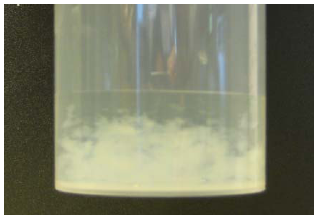
Figure 8. White precipitation in a 4.5 wt% Na-silicate solution containing 25 wt% SSW at 20